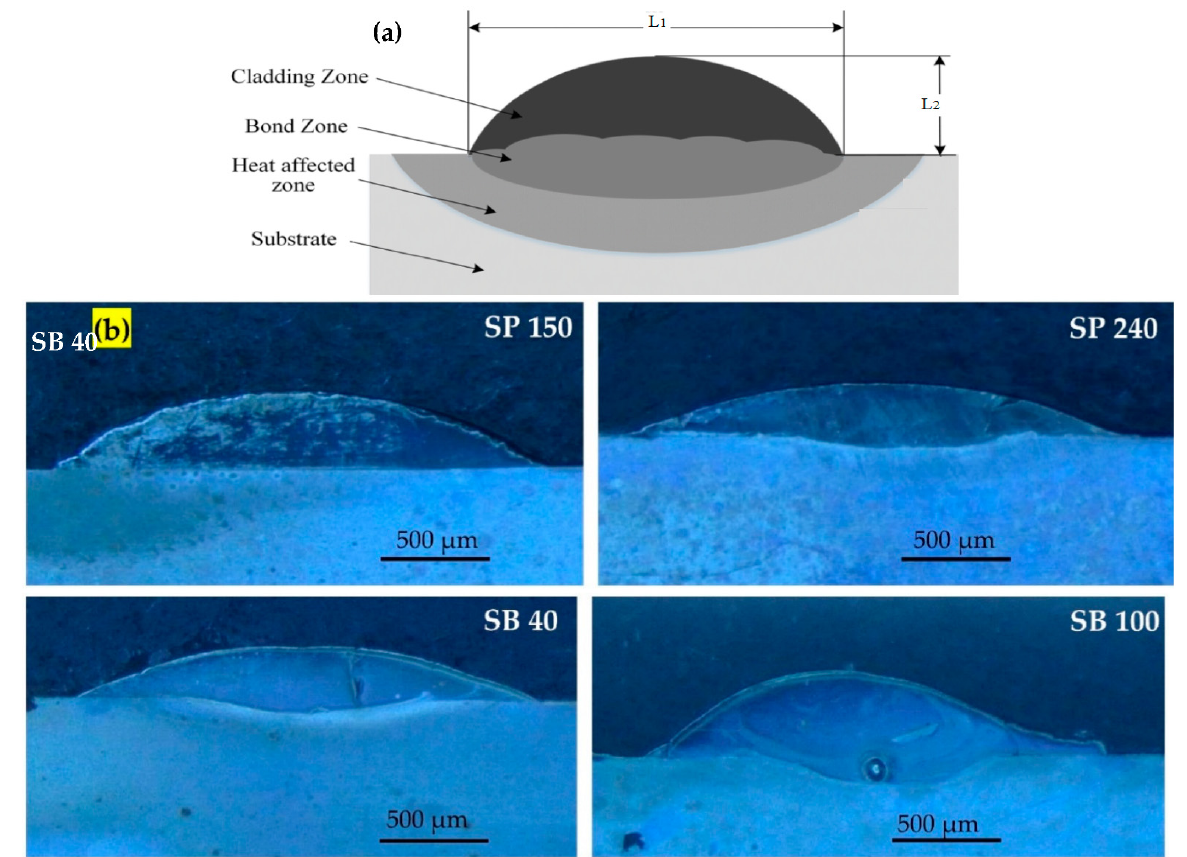
Figure 2. ( a ) Schematic of the cross-section of the laser-cladded single track with track height and width, ( b ) laser-cladded samples, with each sample presenting different surface roughness.